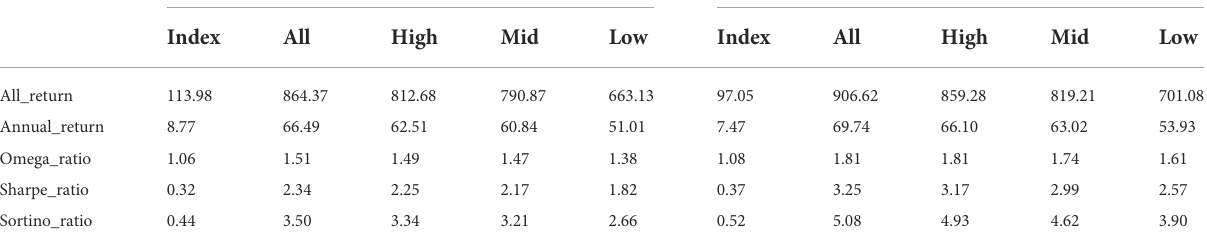
TABLE 4 Evaluation of performance of portfolio using Multi-CNN method with and without carbon factor in feature engineering Note: This table records the values of total return, average return, omega ratio, Sharpe ratio and Sortino ratio used to evaluate the performance of portfolio of Multi-CNN method. And all, high, mid as well as low represent the full stock, high-carbon, medium-carbon as well as low-carbon sectors respectively. Meanwhile, the values of Chinese market and American market are recorded respectively. And SSE Composite Index is selected as benchmark in China, whilethe S&P 500 is selected in America. Compared to the benchmark, the fi vemeasures of investment performance of the portfolio constructed by this methodology far exceed the benchmark, implying a signi fi cantly higher return per unit of risk, which is a positive